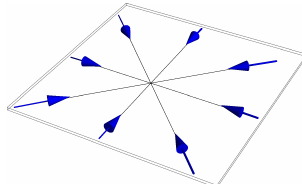
Figure 1. Schematic of experimental set-up with four standing waves at π /4 angles. The light is polarized perpendicularly to the plane of propagation.